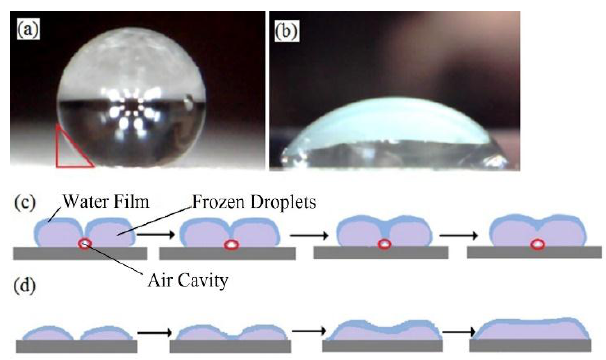
Figure 8. Morphology and convergence process of droplets on C0 and C4 surfaces: ( a ) water drop on C4; ( b ) water drop on C0; ( c ) convergence process of water drops on C4; ( d ) convergence process of water drops on C0.